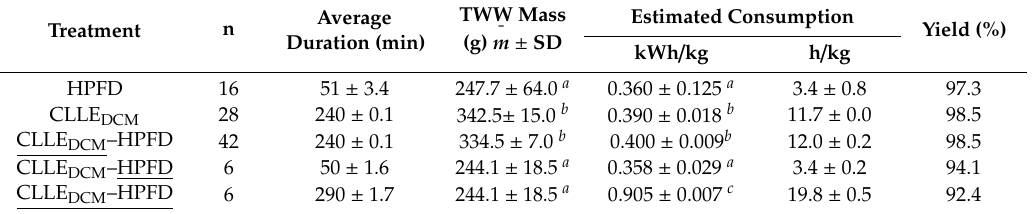
Table 5. Yields and average estimated consumption of time and energy per unit mass of treated water (TWW) obtained by CLLE DCM , HPFD, or CLLE DCM –HPFD (on a laboratory scale) of nondomestic wastewater (WW) of sedimentation ponds in the petroleum production